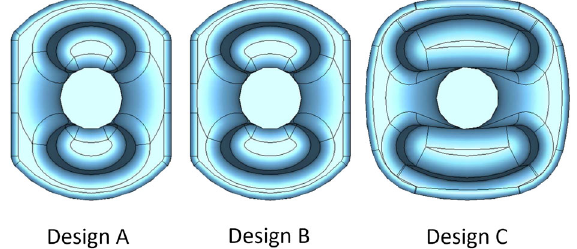
FIG. 20. CAD drawings of the final cavity designs viewed along the beam axis.